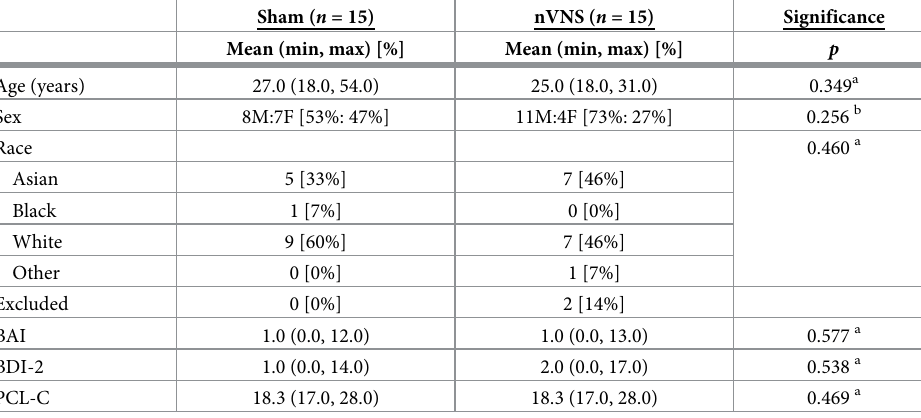
Table 1. Subject demographics and psychiatric